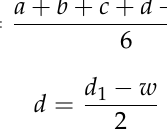
Figure 7. Notch corrosion test procedure: ( a ) the test sample after removal from the salt chamber; ( b ) removal of the coating around the notch; and ( c ) detection of places where the development of corrosion mechanisms occurred.